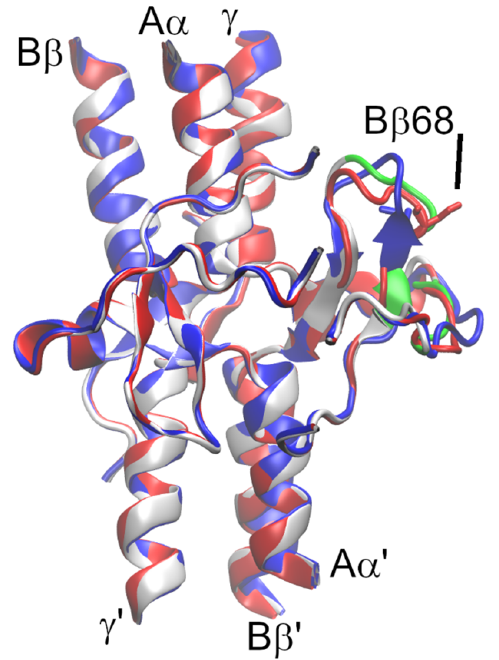
Figure 6. Fit of homology models of mutant (red) and WT structures (blue) onto crystal structure 3GHG (grey). Parts of the crystal structure missing in the alignment are shown in green.